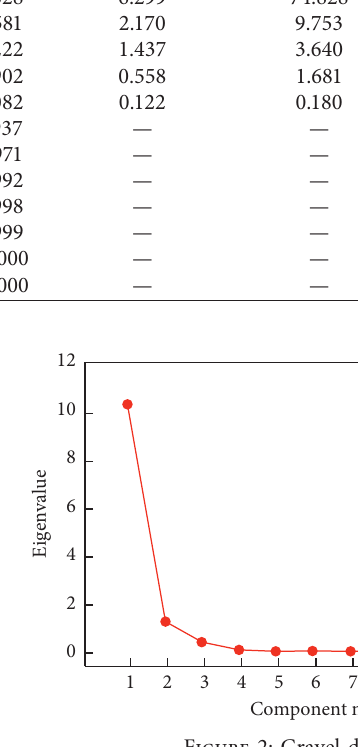
Figure 2: Gravel